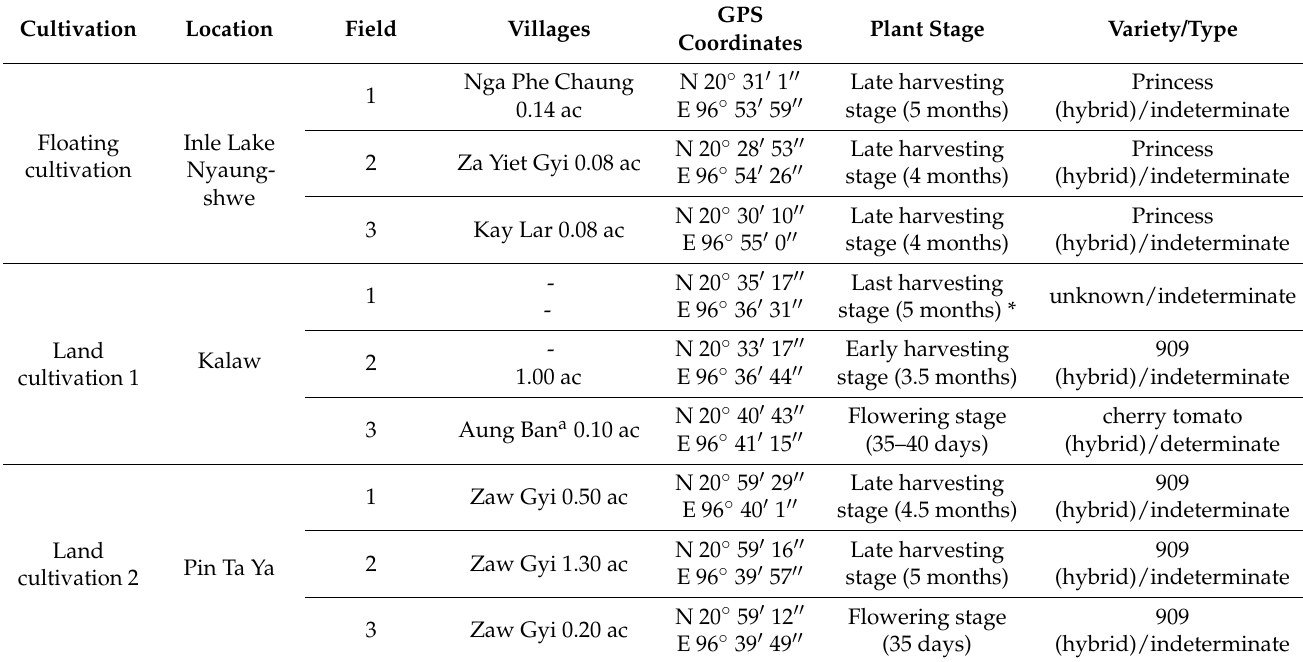
Table 1. Tomato sampling sites used during Tuta absoluta survey atthree locations and two cultivation methods in the South Shan State in